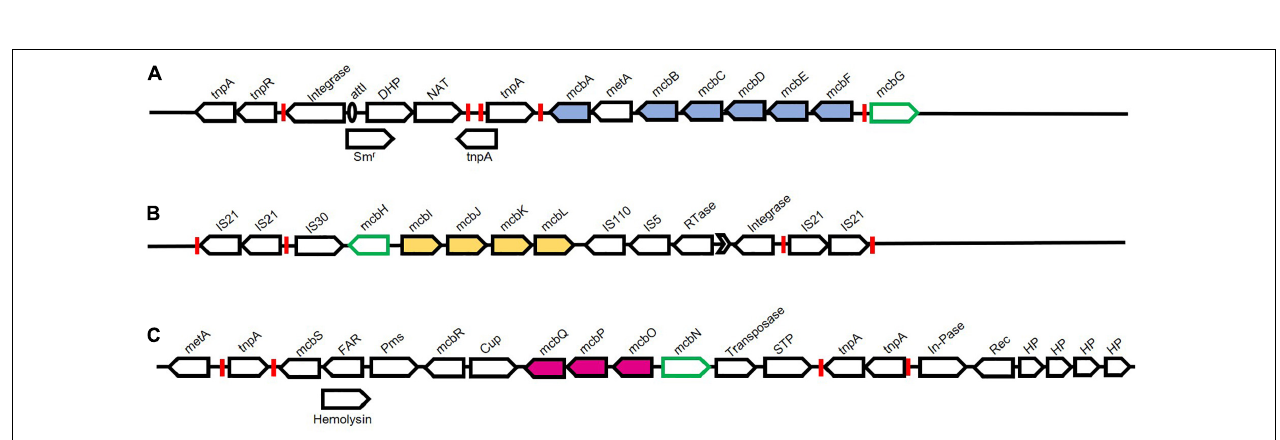
FIGURE 10 | Chromosomal organisation of genes associated with Carbaryl degradation from Pseudomonas sp. strain C5pp. Pathway genes are depicted as filled arrows while black open arrows depict mobile genetic elements and associated genes. Green open arrows depict putative regulators. Various inverted repeats are depicted as red boxes. (A) Upper pathway genes encode enzymes involved in the conversion of Carbaryl to salicylate. Genes and protein encoded are Transposase ( tnpA and tnpR ); Integrase; attI site (unfilled oval); Streptomycin resistance (Sm r ); Dihydropterate synthetase (DHP); N -Acetyltransferase (NAT); tnpA , Transposase; mcbA , Carbaryl hydrolase; metA , conserved protein; mcbB , 1,2-Dihydroxynaphthalene dioxygenase; mcbC , 1-Naphthol 2-hydoxylase; mcbD , 2-Hydroxychromene 2-carboxylate isomerase; mcbE , Trans - o -hydroxybenzylidene pyruvate hydratase-aldolase; mcbF , Salicylaldehyde dehydrogenase; mcbG , LysR family regulator. (B) Middle pathway genes encode enzymes involved in the conversion of salicylate to gentisate. Genes and protein encoded are: IS21 insertion elements flanked by inverted repeats; IS30 insertion element; mcbH , transcriptional regulator NahR; mcbI , Ferredoxin reductase; mcbJ , Salicylate 5-hydroxylase large oxygenase component; mcbK , Salicylate 5-hydroxylase small oxygenase component; mcbL , Ferredoxin; IS110 and IS5 insertion elements; Rtase, Reverse transcriptase; group-II intron (Black arrow head); Integrase; IS21 insertion elements flanked by inverted repeats. (C) Lower pathway genes encode enzymes involved in the conversion of gentisate to central carbon pathway intermediates. Genes and protein encoded are : metA , conserved protein; tnpA , Transposase; mcbS , TetR family transcriptional regulator; FAR, Fusaric acid resistance; Hemolysin; Pms, Permease; mcbR , LysR family transcriptional regulator; Cup, Pirin and cupin2 superfamily related protein; mcbQ , Maleylpyruvate isomerase; mcbP , Fumaryl pyruvate hydrolase; mcbO , Gentisate dioxygenase; mcbN , LysR family transcription regulator; Transposase; STP, Serine/threonine phosphatase; tnpA , Transposase; In-Pase, Inositol phosphatase; Rec, Recombinase; HP, Hypothetical